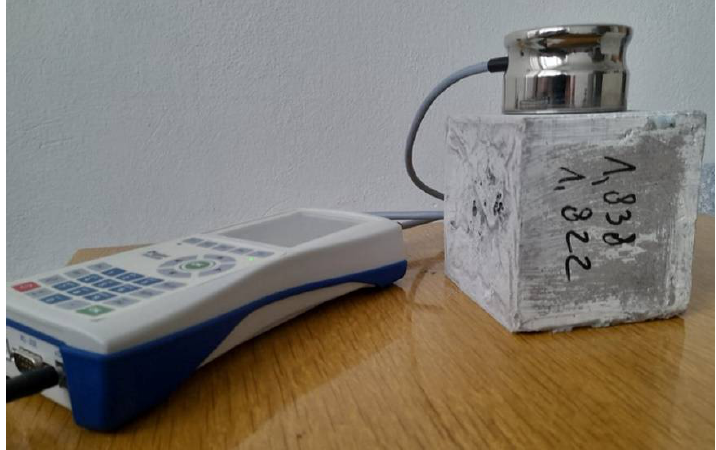
Figure 5. Investigation of the thermal properties of the modified geopolymer samples.